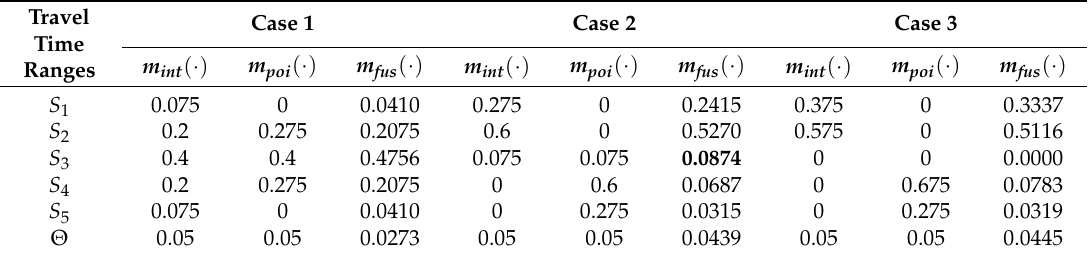
Table 2. Simple example of distribution fusion using the generalized combination